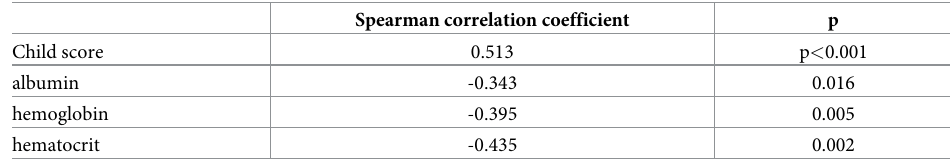
Table 2. Correlation of heart rate turbulence (TO) with Child-score and biochemical